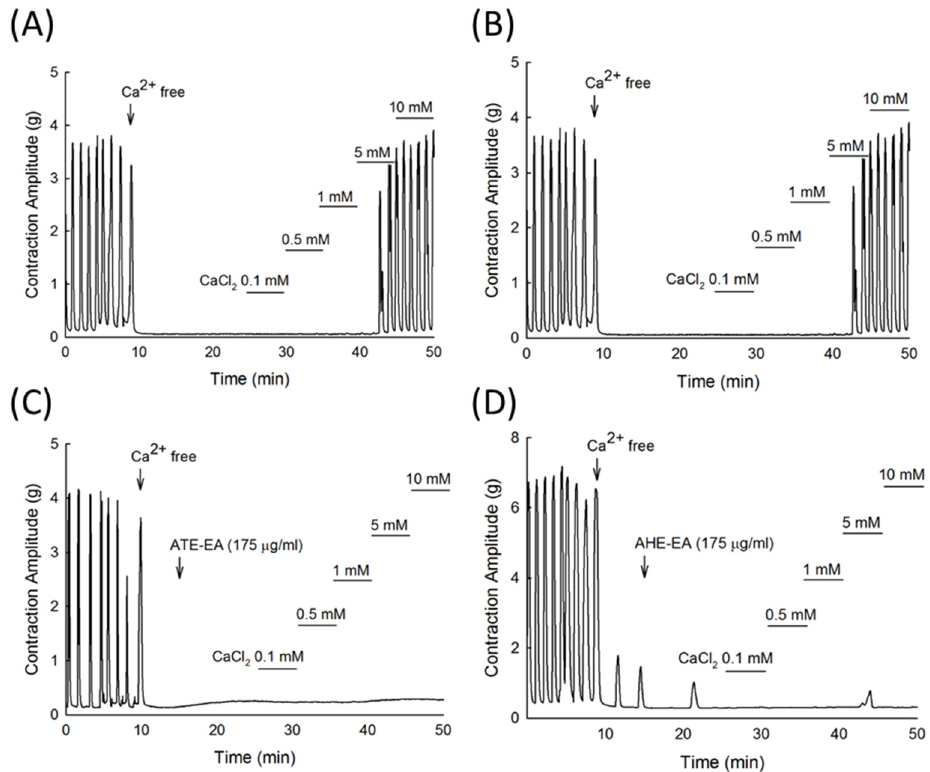
Figure 4. Inhibitory effect of ATE-EA and AHE-EA on calcium (Ca 2+ )-dependent contractile responses ex vivo. ( A , B ) Calcium chloride (0.1–10 mM) added into the bathing solution resulted in a concentration-dependent increase in contraction of the isolated rat uterus, which was inhibited by ( C ) ATE-EA (175 µg/mL) and ( D ) AHE-EA (175 µg/mL).